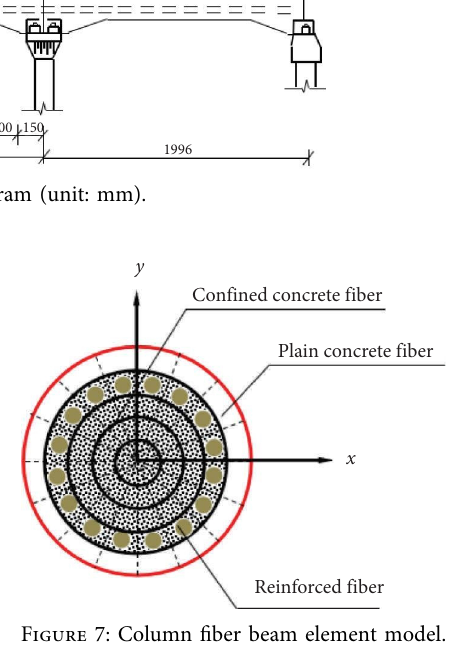
Figure 5: Cross section diagram of aqueduct (unit: mm).